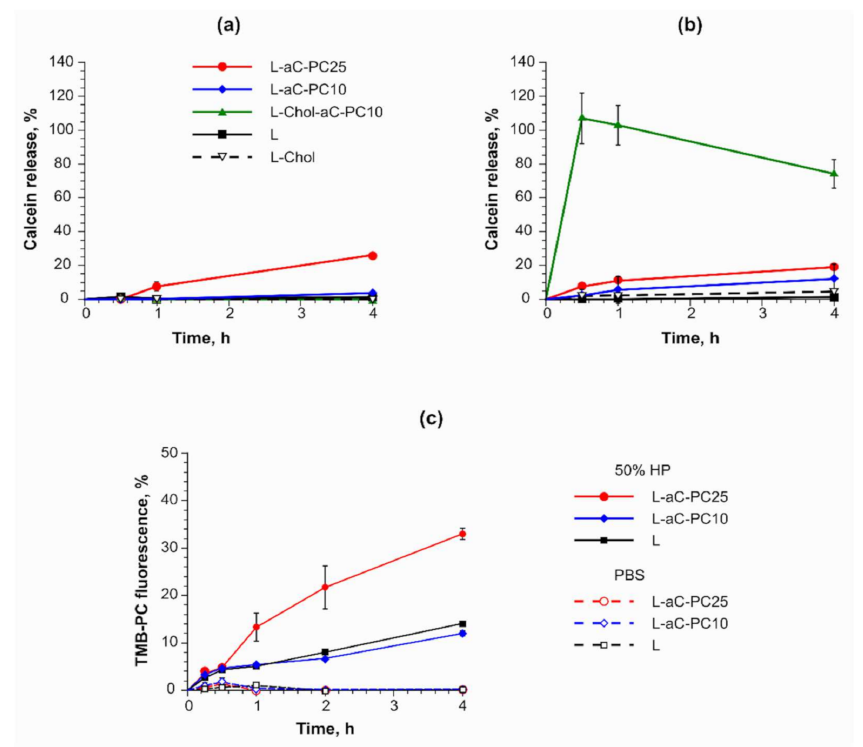
Figure 2. ( a,b ) Calcein release assay for cholesterol-free L-aC-PC10 and L-aC-PC25 liposomes and relevant control (L) and cholesterol-containing L-Chol-aC-PC10 and L-Chol control in ( a ) PBS and ( b ) 50% human plasma (HP). Mean ± SD are reported. n = 3. ( c ) FRET assay utilizing the TMB-PC and BCHB-PC pair of lipid bilayer probes in L-aC-PC10, L-aC-PC25, and control (L) liposomes in PBS and 50% HP. n = 2. Mean ± SE are reported. For sample designations, see Table